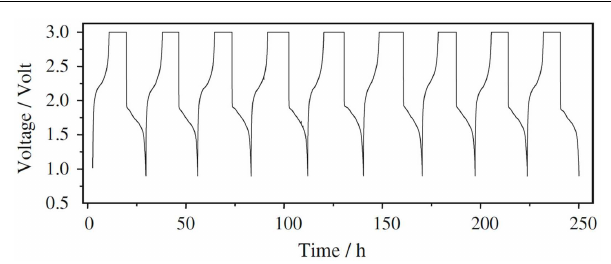
FIGURE 5 |Voltage profile of charge and discharge for a prototype Li-ion cell using a prelithiated SPAN cathode, a graphite anode, and a 1M LiPF 6 1:1 (vol.) EC-DEC electrolyte, cycled at 0.1C . Reproduced with permission of He et al.